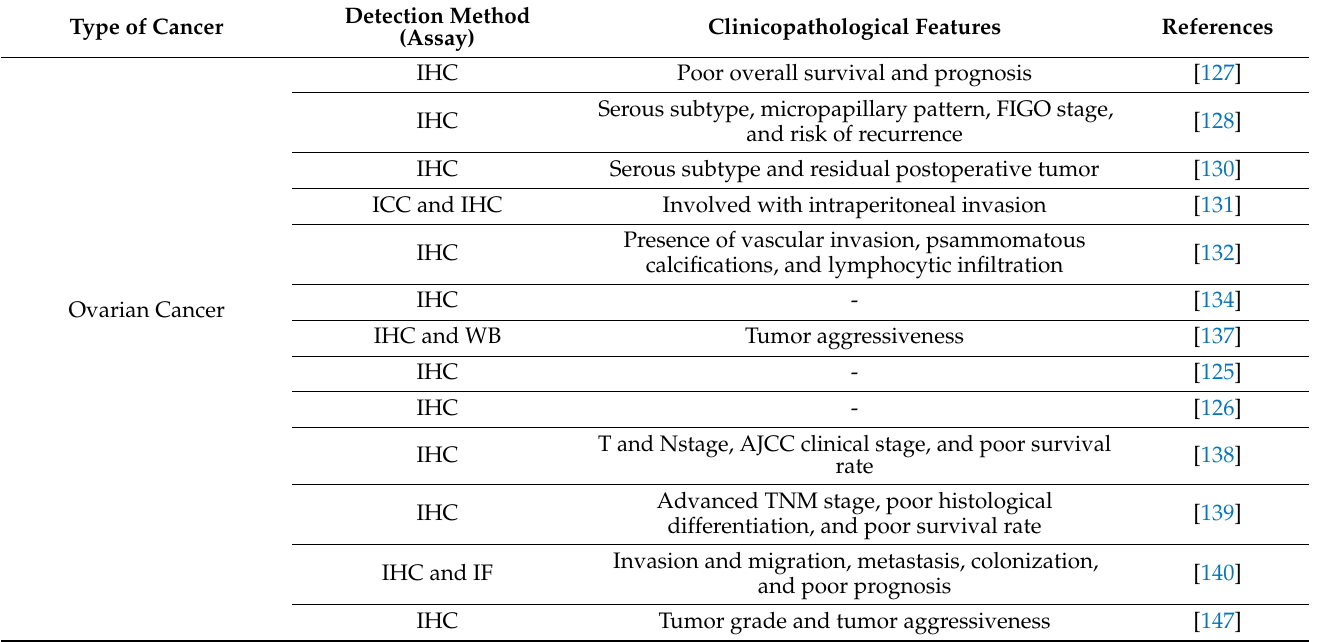
Table 1. Fascin Overexpression in Gynecological Cancers and its Association with Clinico-pathological Features. Type of